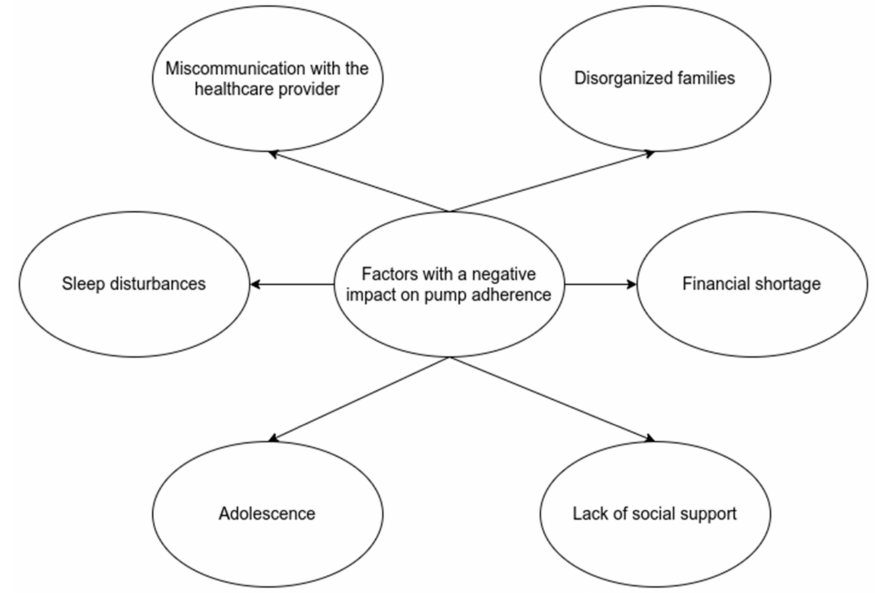
Figure 2. Factors with a negative impact on pump